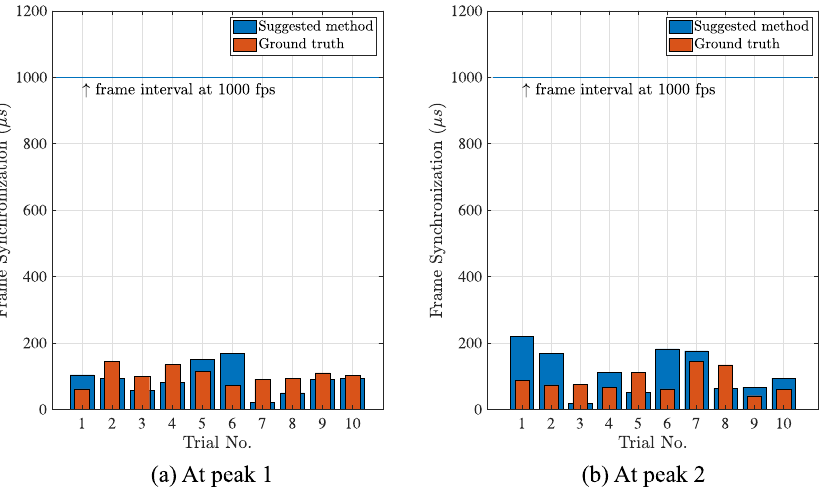
Figure 12. Estimated accuracy of frame synchronization. The frame synchronization was estimated by the suggested method (blue) at the sub-frame resolution. Compared to the ground truth (red), the average differences were 1.6% and 2.9% of the full frame interval 1000 µ s (blue line) at two observation points ( a , b ). The estimation accuracy was the order of tens of